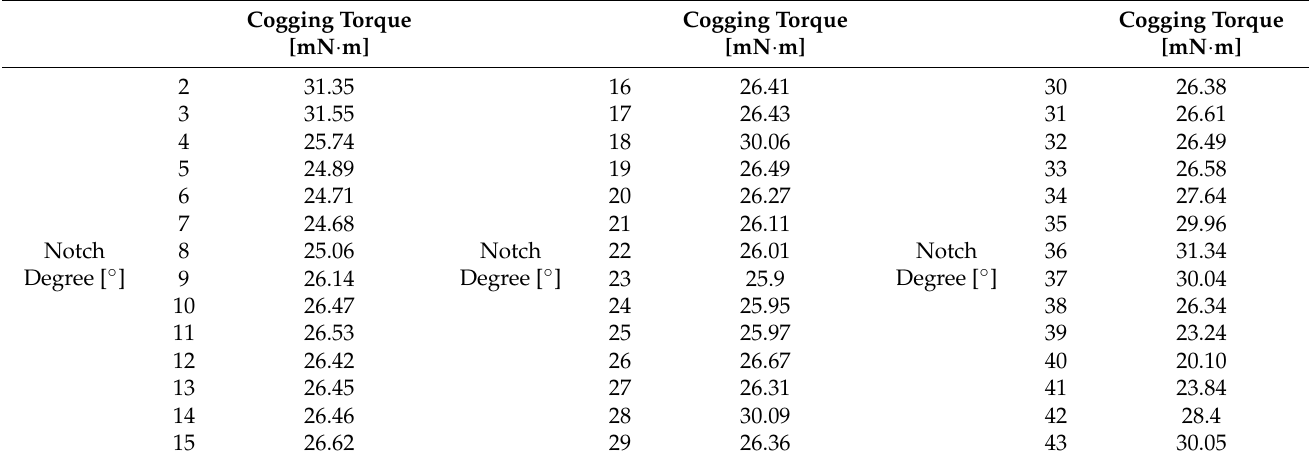
Figure 6. 1 notch model for trend analysis. Table 2. Cogging torque result of 1 notch